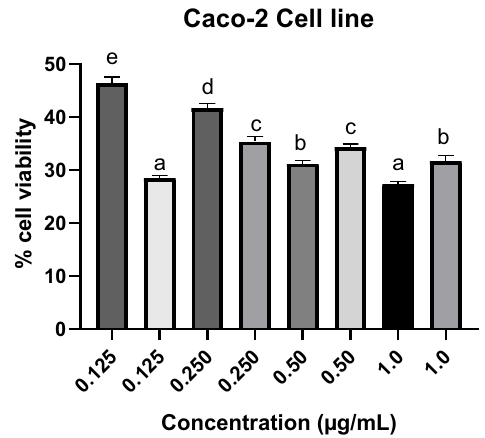
Figure 6: Cytotoxic e ff ect of extract and AgNPs@Org on Caco - 2 cell lines. The fi rst and second columns indicate the extract and nano - particles, respectively. Di ff erent letters indicated signi fi cantly dif - ferent ( p < 0.05 ) compared in each assay.